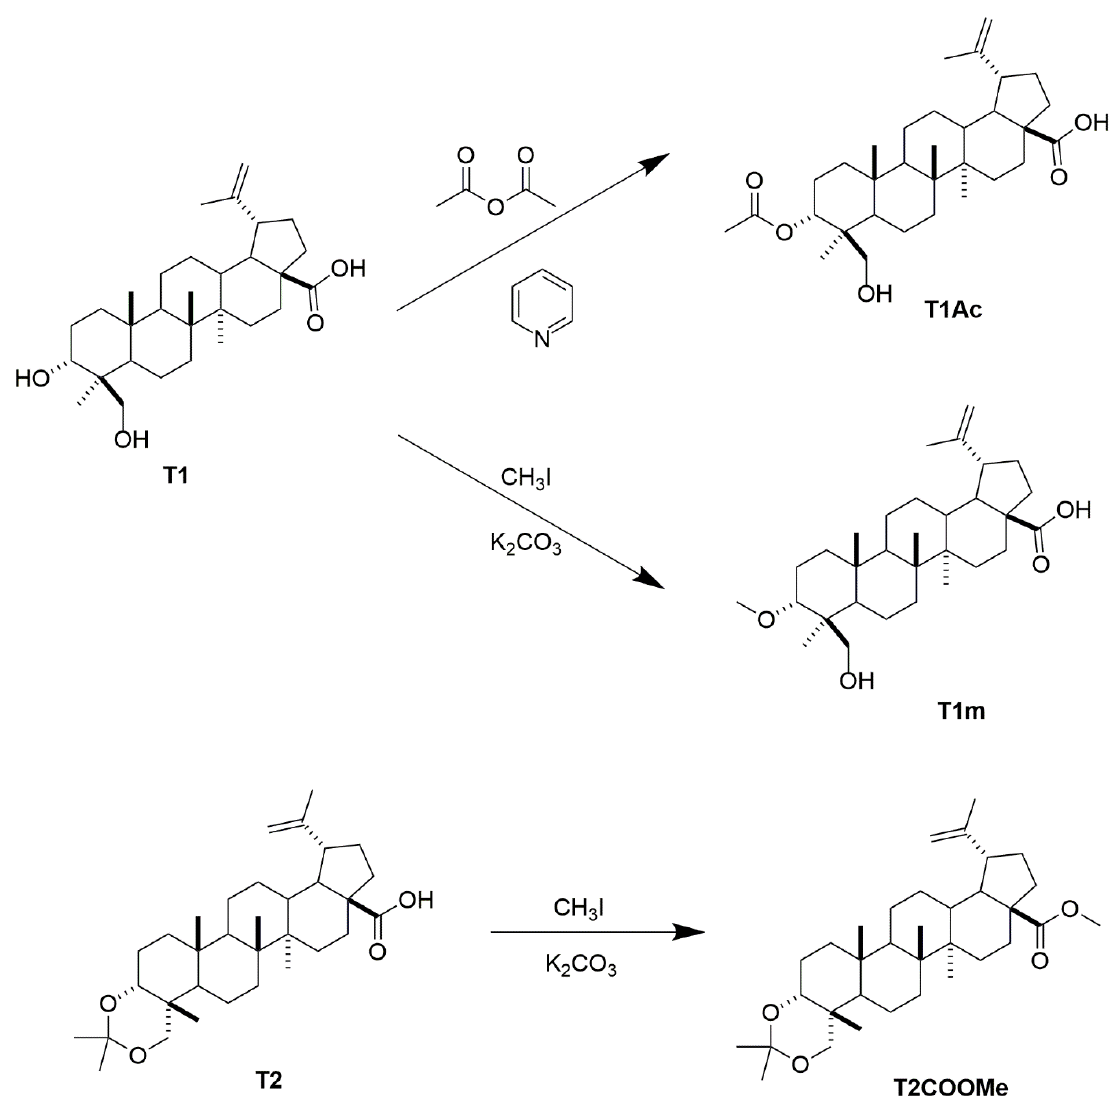
Figure 1. Synthesis of compounds T1Ac , T1m, and T2COOMe . Table 1. Mean inhibitory concentrations of the lupane skeleton triterpenes were evaluated against the K562, HL60, VERO, and MNC cell lines.